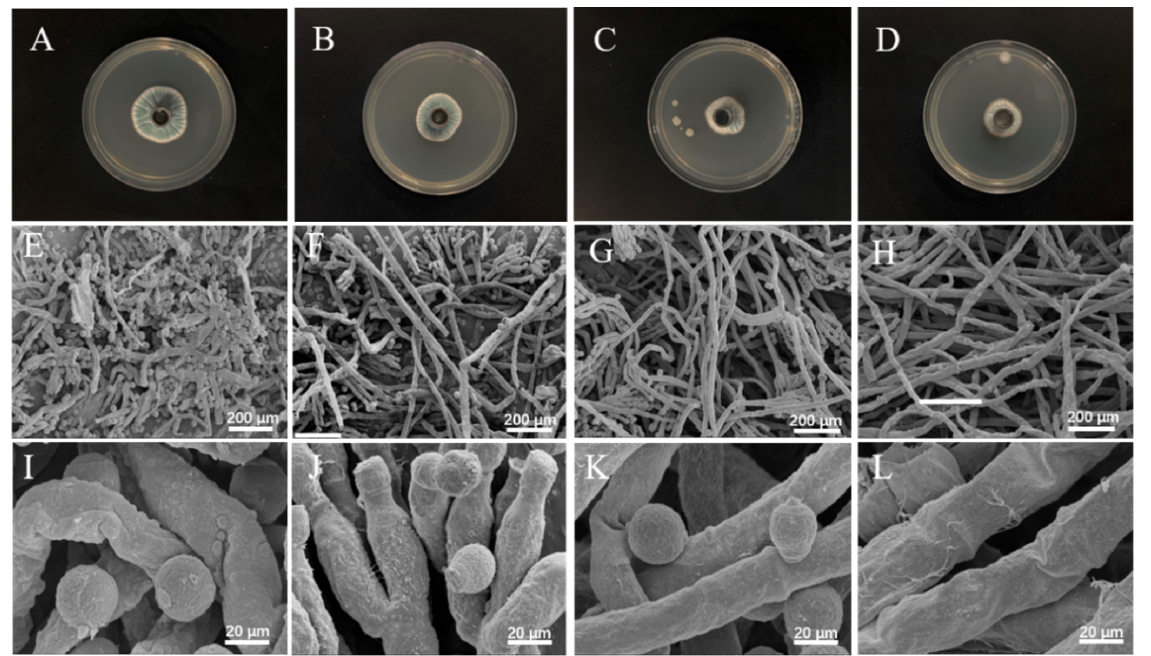
Figure 2. ( A – D ) Samples used for SEM observation. ( E – L ) Morphologies of the mycelia and conidia of P. italicum were observed by SEM after treatments with 0 ( E , I ), 1/2 MIC of P. italicum were observed by SEM after treatments with 0 ( E , I ), 1/2 MIC ( F , J ), MIC ( G , K ), and ( F , J ), MIC ( G , K ), and 2 MIC PCT nanoemulsions ( H , L ). Scale bar, 200 and 20 μ m. 2 MIC PCT nanoemulsions ( H , L ). Scale bar, 200 and 20 µ m.